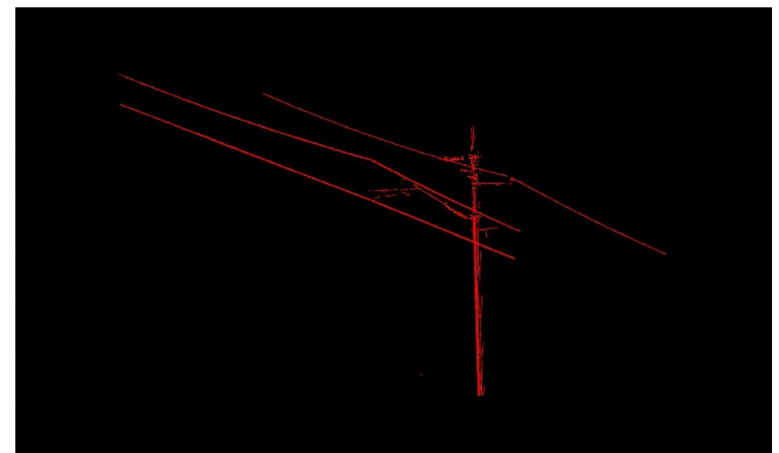
Figure 6. Railway OCS point cloud with a length of 50 m.